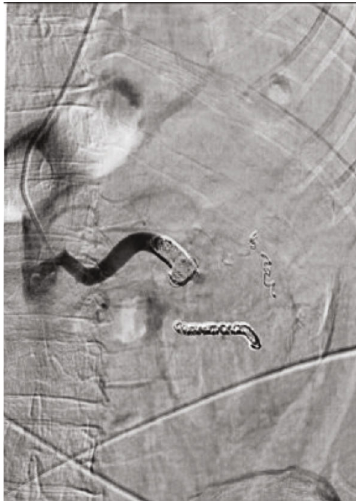
Figure 4: Status post selective coil embolization of the main renal artery at the level of the AVM with absence of early venous fi lling.